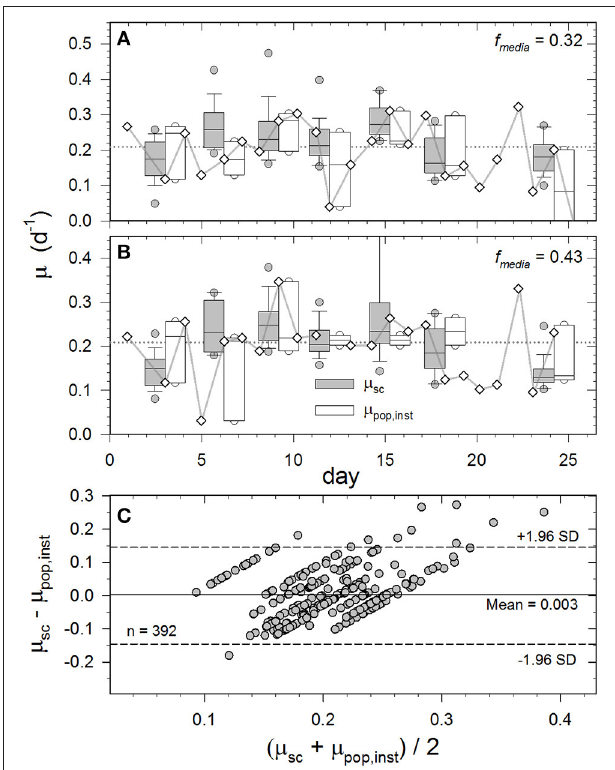
FIGURE 6 | Temporal variations in single-cell growth rates ( µ sc ) calculated 1 ˜ ν C − C from SCRR peak positions and daily population growth rates (cid:10) (cid:11) ( µ pop,inst –diamonds) based on in vivo fluorescence measurements (Figure S1) for cultures incubated in f media = 0.32 (A) and 0.43 (B) , and Bland and Altman (1986) plot comparing results from both methods and treatments (C) . See Materials and Methods for calculations. Box and whisker plot details are as described in Figure 3 . Shaded boxes represent single-cell growth rates ( µ sc ) and open boxes represent daily population growth rates ( µ pop,inst ) at t x − 1 , t x, and t x + 1 . Horizontal broken line is mean µ pop over entire exponential growth phase (0–18 days). (C) Differences between µ sc and µ pop,inst compared to their mean values to assess their agreement. Broken horizontal lines represent the 95% confidence intervals ( ± 1.96 standard